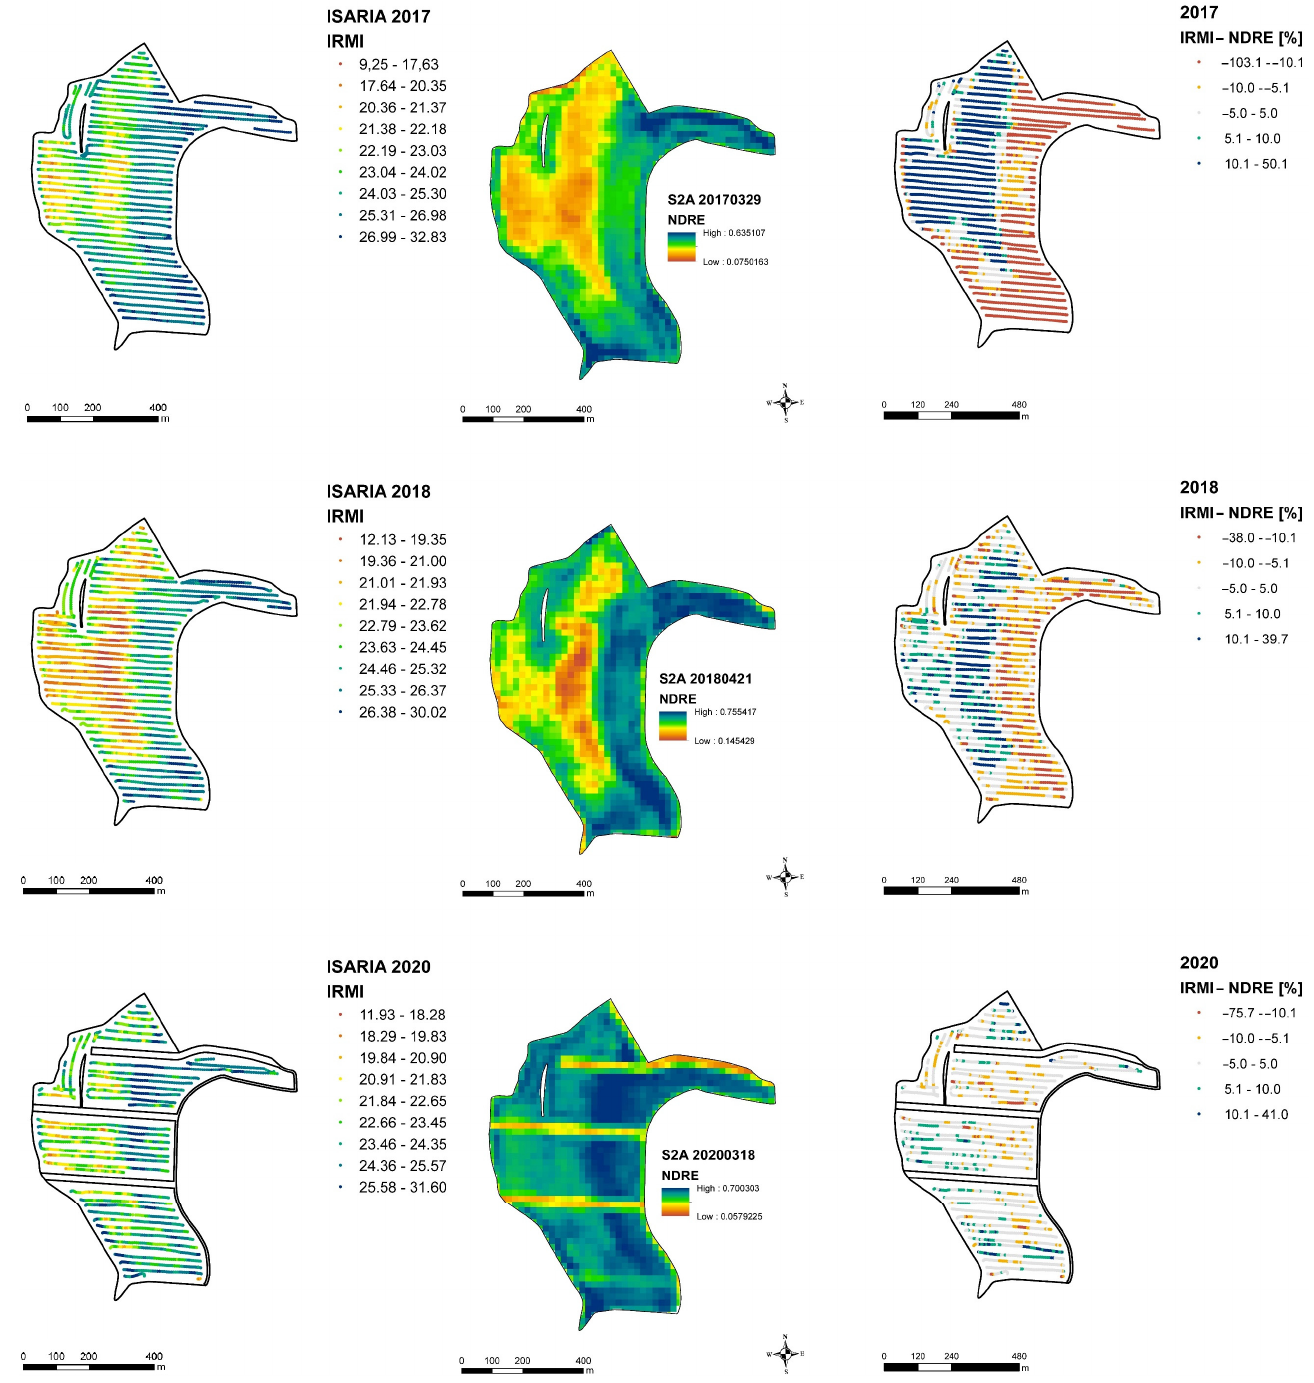
Figure A3. Example of the comparison of proximal and remote sensing on experimental field ID 3003_12 in the selected years: vegetation index ISARIA IRMI ( left ); vegetation index Sentinel-2 ( middle ); relative (%) comparison of differences between the two sensing systems ( right